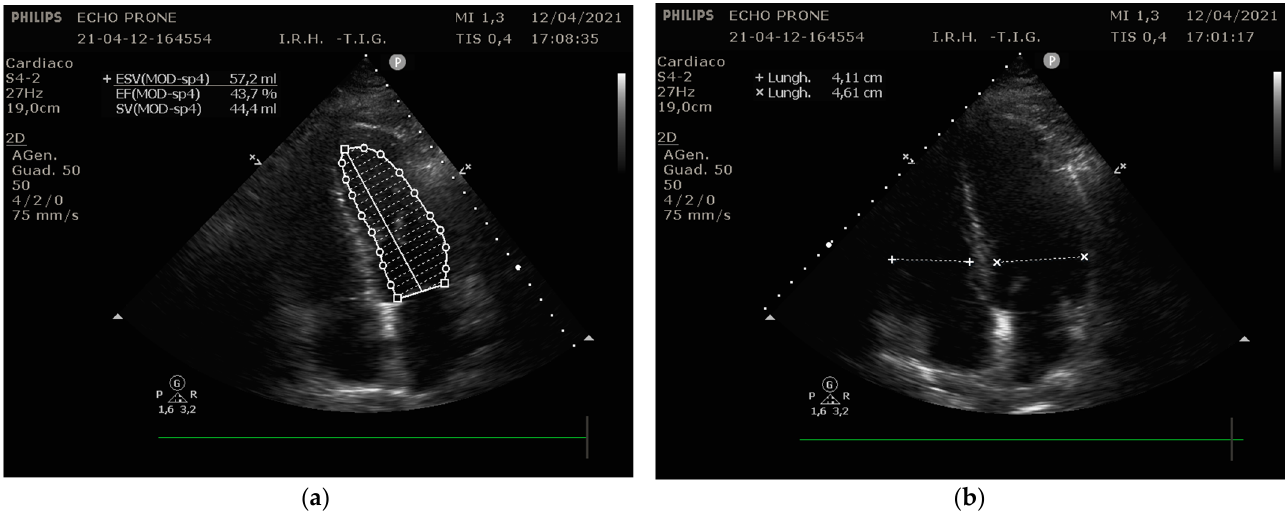
Figure 3. TTE apical-four-chamber views in prone position in a patient with COVID-19 ARDS. ( a ) Ejection Fraction estimation. ( b ) Ventricle diameter measurements are shown.